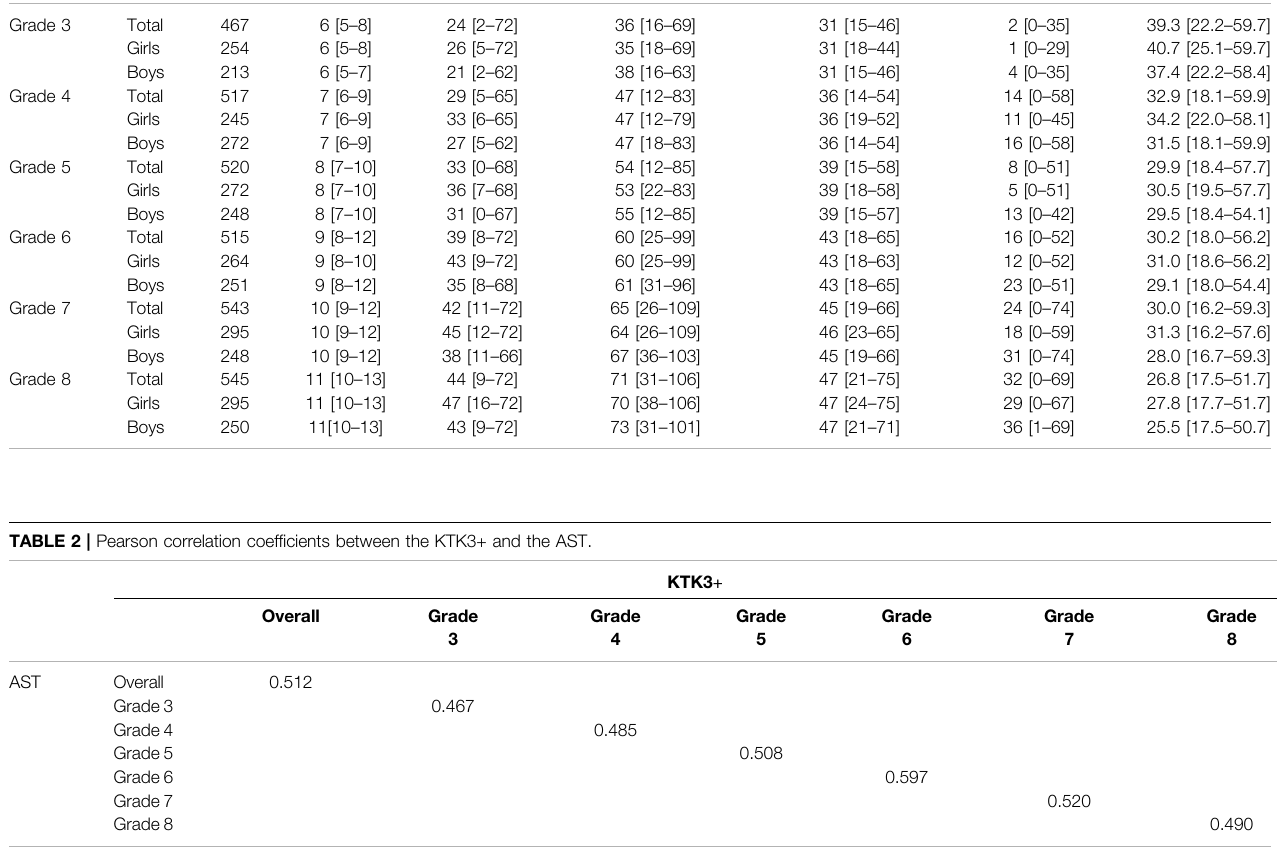
TABLE 1 | Raw scores (median with minimum and maximum value) of children from grades 3 through 8 on the four subtests of the KTK3+ (number of successful attempts) and the AST (time in seconds).